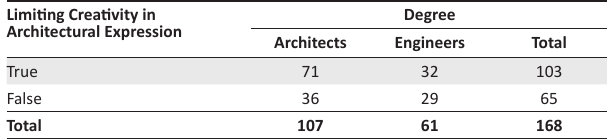
TABLE 14: Limitation of creativity in architectural expression.